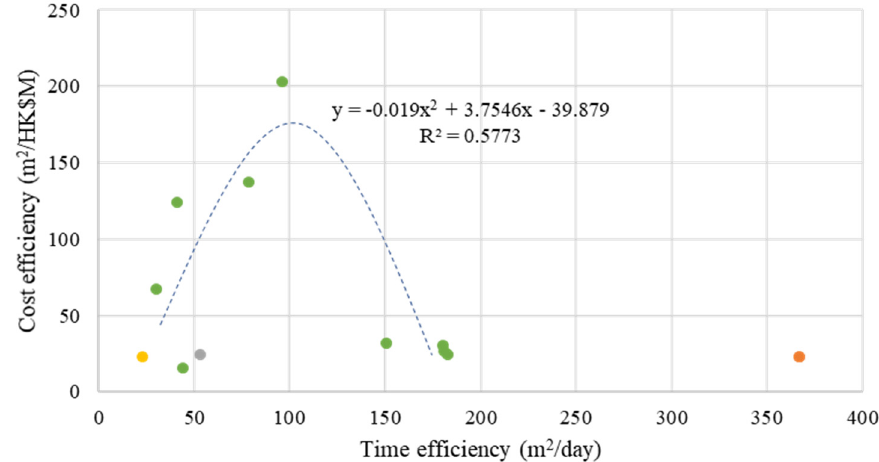
Figure 7. Measured time-efficiency and cost-efficiency. Notes: green dots − Projects A to I (modular QCs); yellow dot − Project J (conventional QC); orange dot − Project K (modular hospital); grey dot − Project L (conventional hospital).